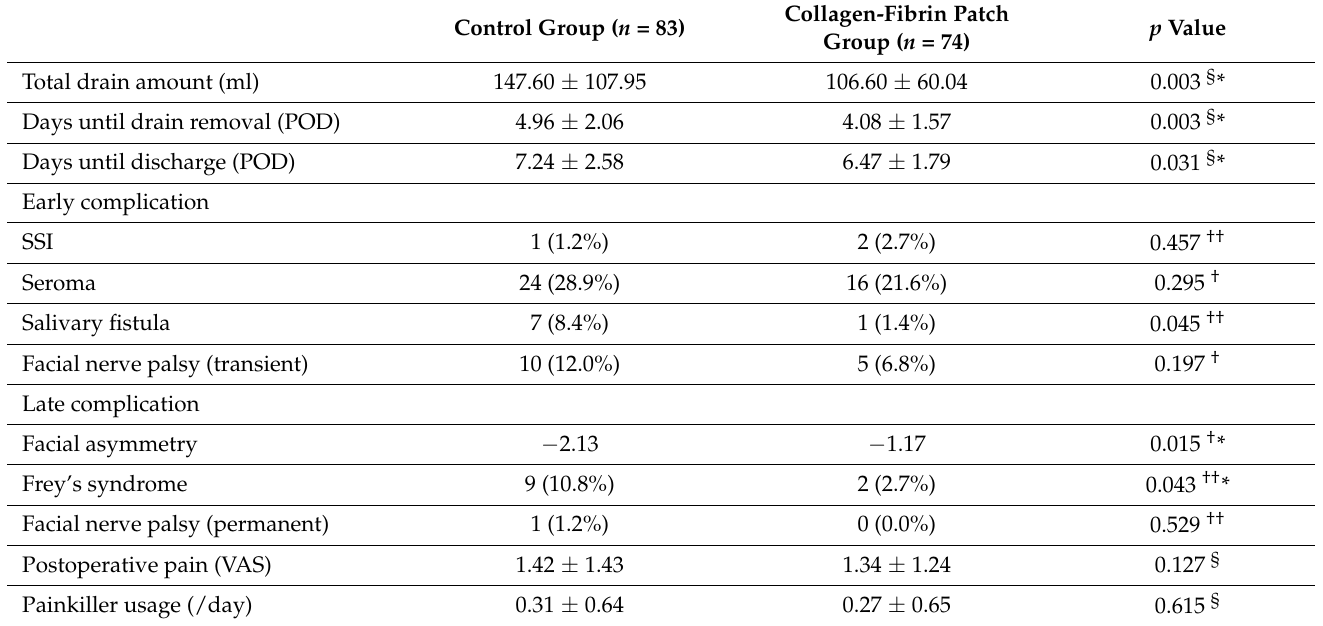
Table 3. The result of primary outcome and complications between